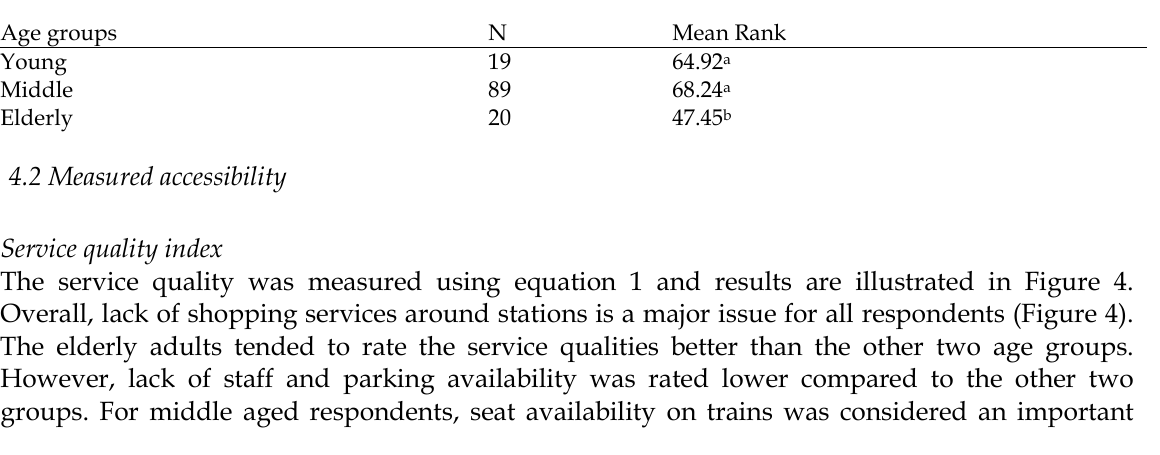
Table 4. Summary of mean ranks based on a Kruskal-Wallis test for Greenwood Station. Different subscripts denote significantly different mean ranks between the age